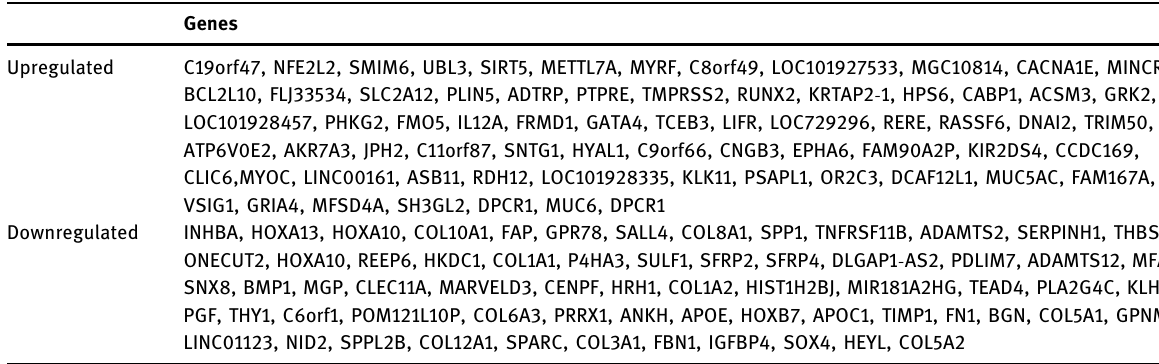
Table 1: DEGs in the GSE19826 dataset Genes